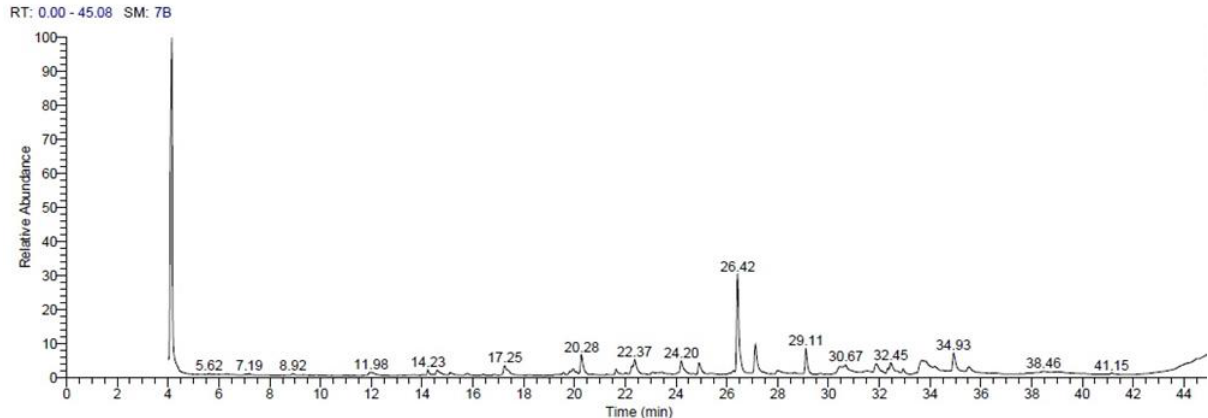
Figure 1. The GC-MS chromatogram of the ethanolic avocado seed extract shows the structures of various phytochemicals at retention times (RT) 4 – 44 min.